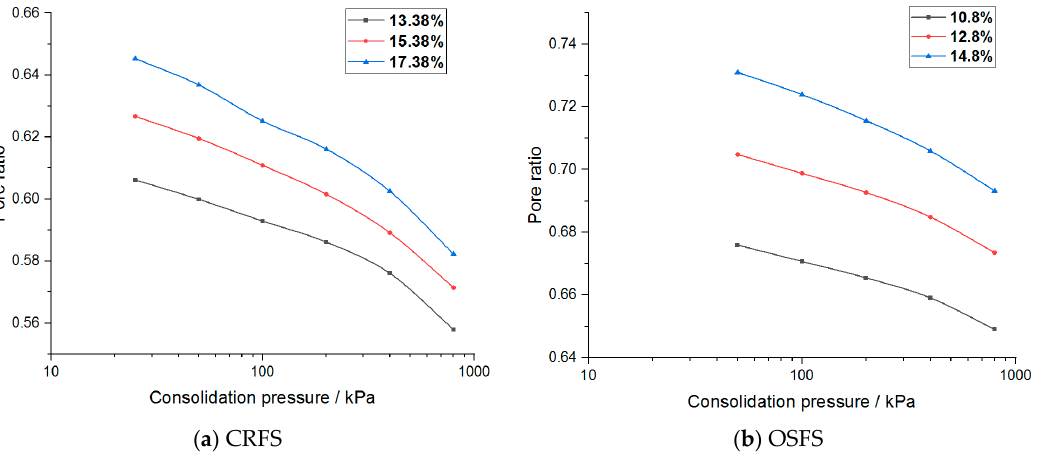
Figure 14. Logarithmic curve of pore ratio and stress of modified soil with different water contents.